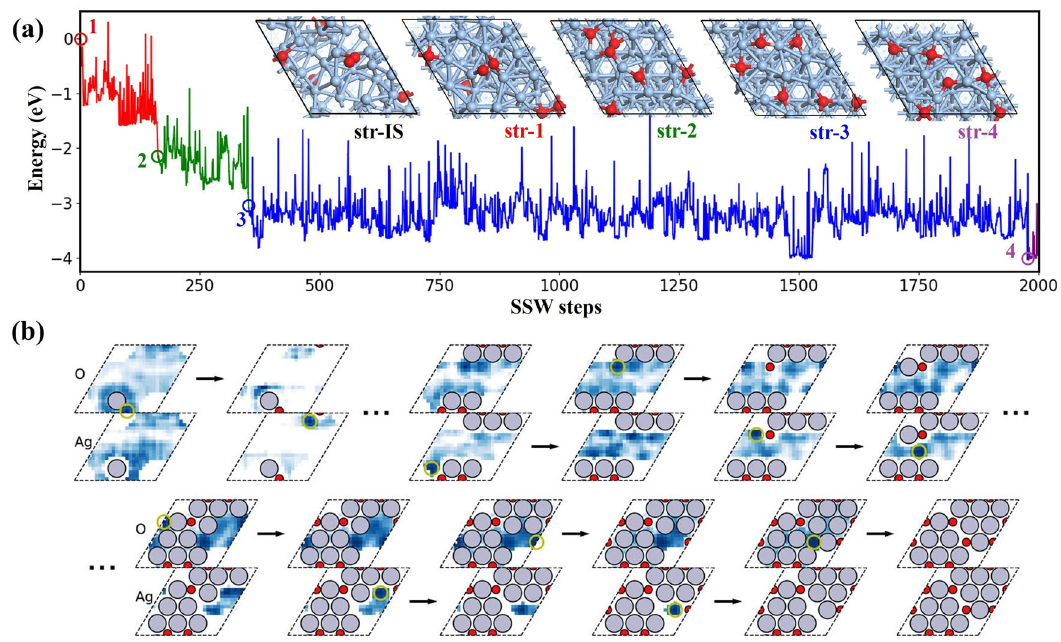
Fig. 1 The identi fi cation of silver surface oxide. a The 2000-step SSW-NN trajectory for identifying the structure of silver surface oxide (Ag 12 O 6 phase on p(4 × 4) supercell of Ag(111)). The initial structure (IS) and four representative structures under different stage of optimization during SSW-NN are shown. b The building of Ag 12 O 6 optimal surface phase with the given input of p(4 × 4) supercell and Ag 12 O 6 composition by reinforcement learning based atomistic structure learning algorithm, in which the depth of blue in the fi gure represents the Q-values (the preference for the location of the next atom) predicted by the CNN, reproduced with permission from ref. 89 . Copyright American Institute of Physics,